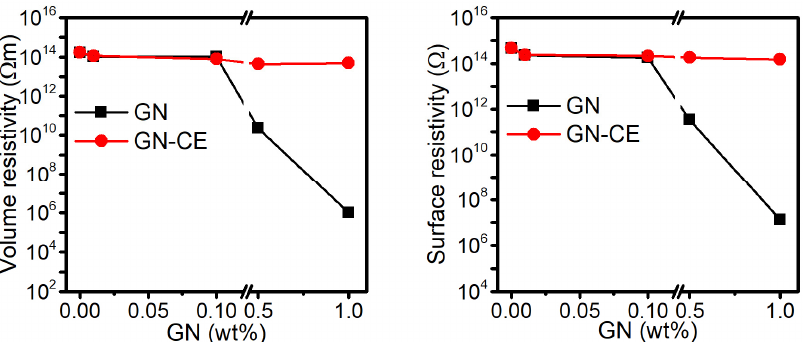
Figure 13. Surface and volume resistivity of PVC, PVC/GN and PVC/GN–CE nanocomposites.